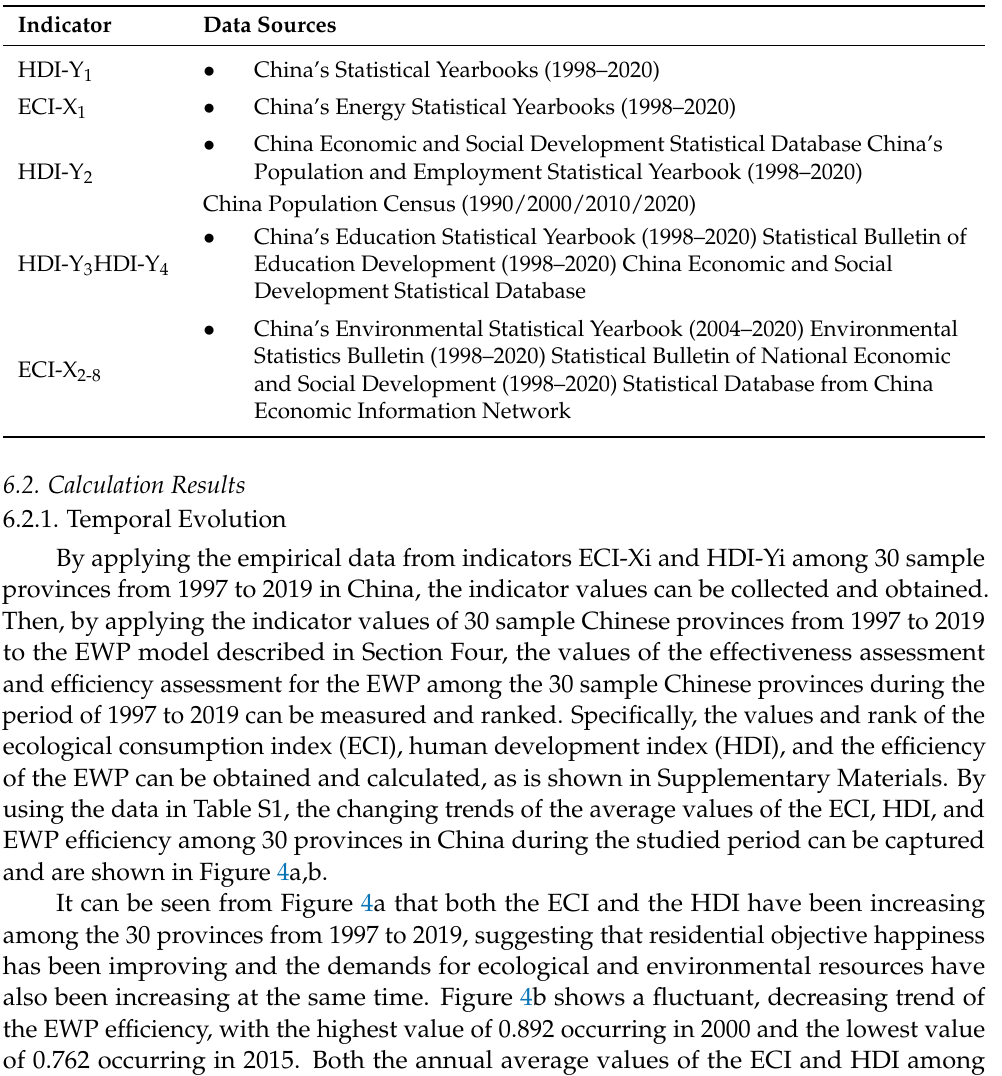
Table 7. Data sources of all indicators for the EWP